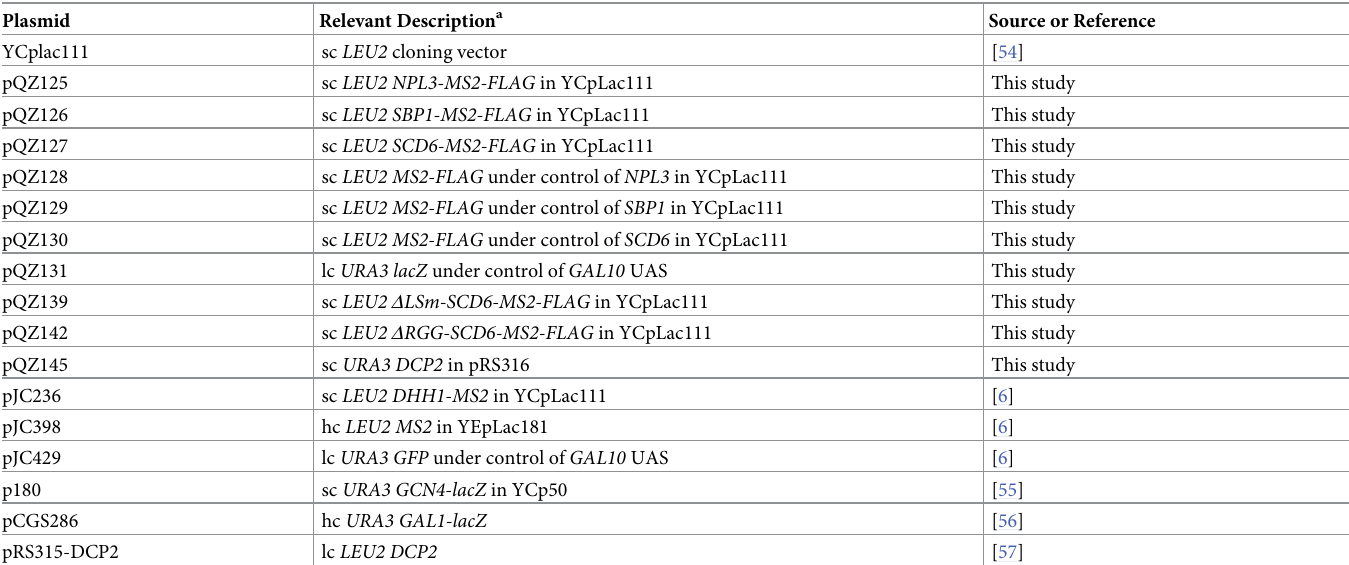
Table 1. Plasmids used in this study.